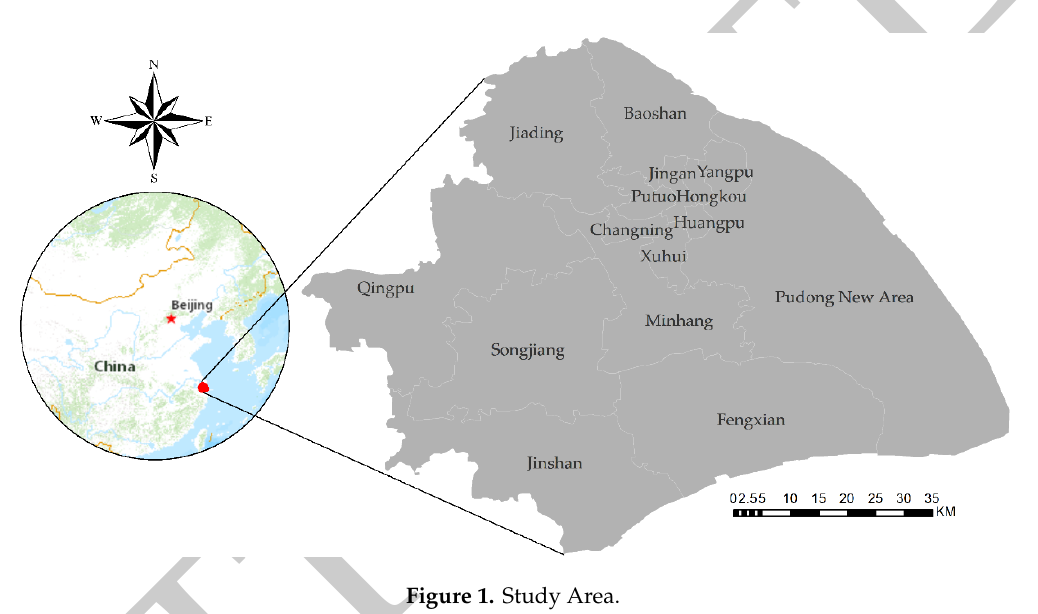
Figure 1. Study Area.